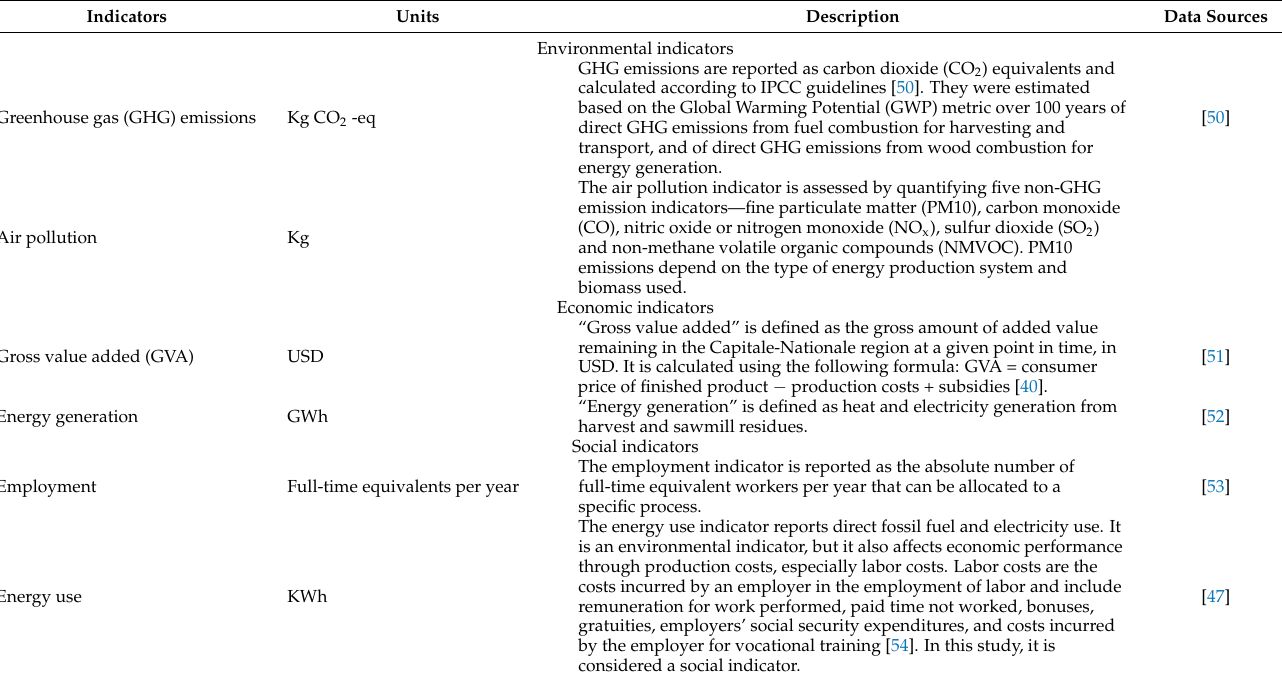
Table 4. Indicator details and data